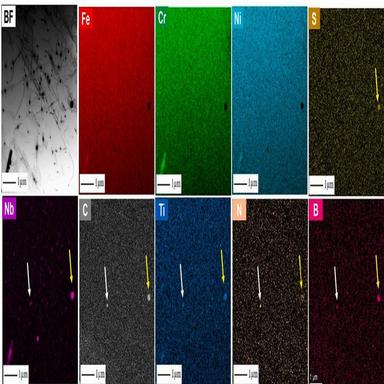
Characterization of alloy 709 crept at 500 ◦C. Chemical maps showing Nb, C, B, Ti, and N rich (White Arrow) and Nb, C, B, Ti, N, and S rich (Yellow Arrow) precipitates. (For interpretation of the references to colour in this figure legend, the reader is referred to the web version of this article.)